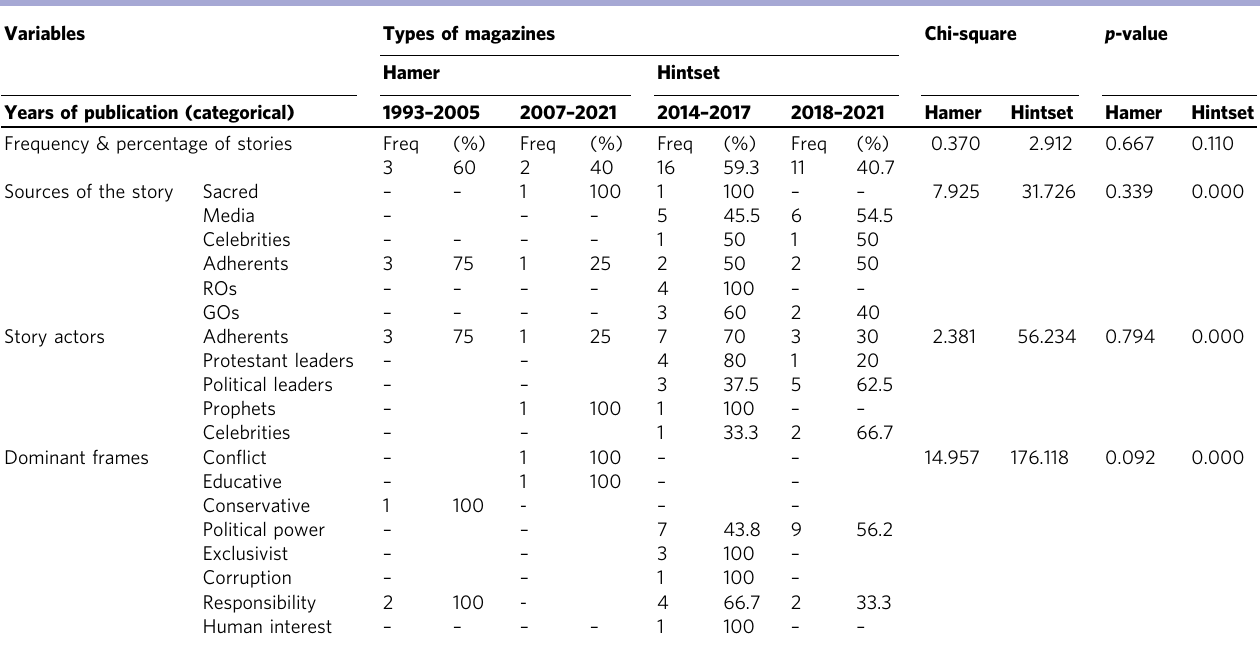
Table 3 Cross-Tabulation: Political development * Types of publication * Years of publication * Sources * Story actors * Dominant